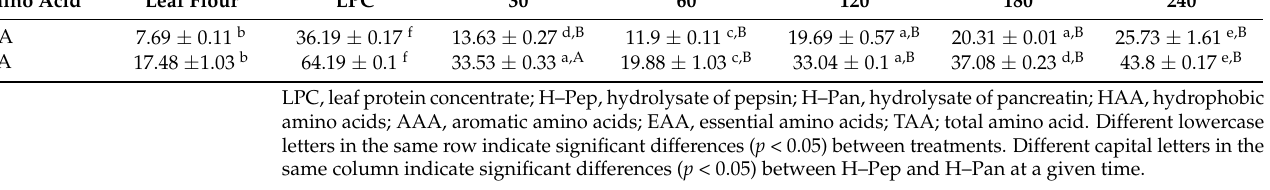
H–Pep at Different Hydrolysis Times